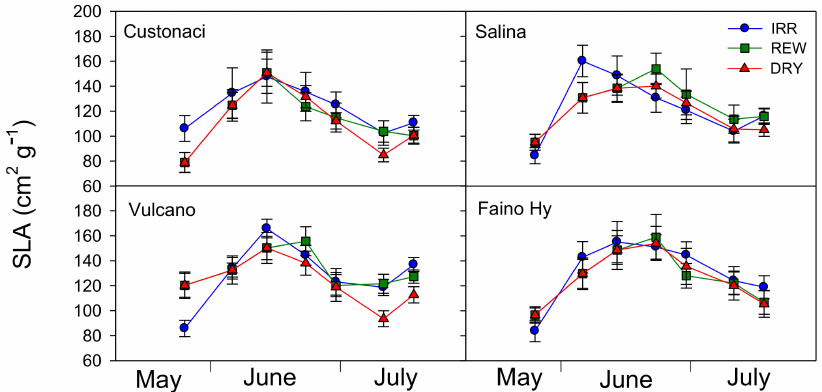
Figure 4. Specific leaf area (SLA, cm 2 g − 1 ) in four genotypes of tomato in relation to the irrigation treatment (IRR: full irrigation; REW: rewatering; DRY: no irrigation). Vertical bars indicate the standard error ( n = 3).